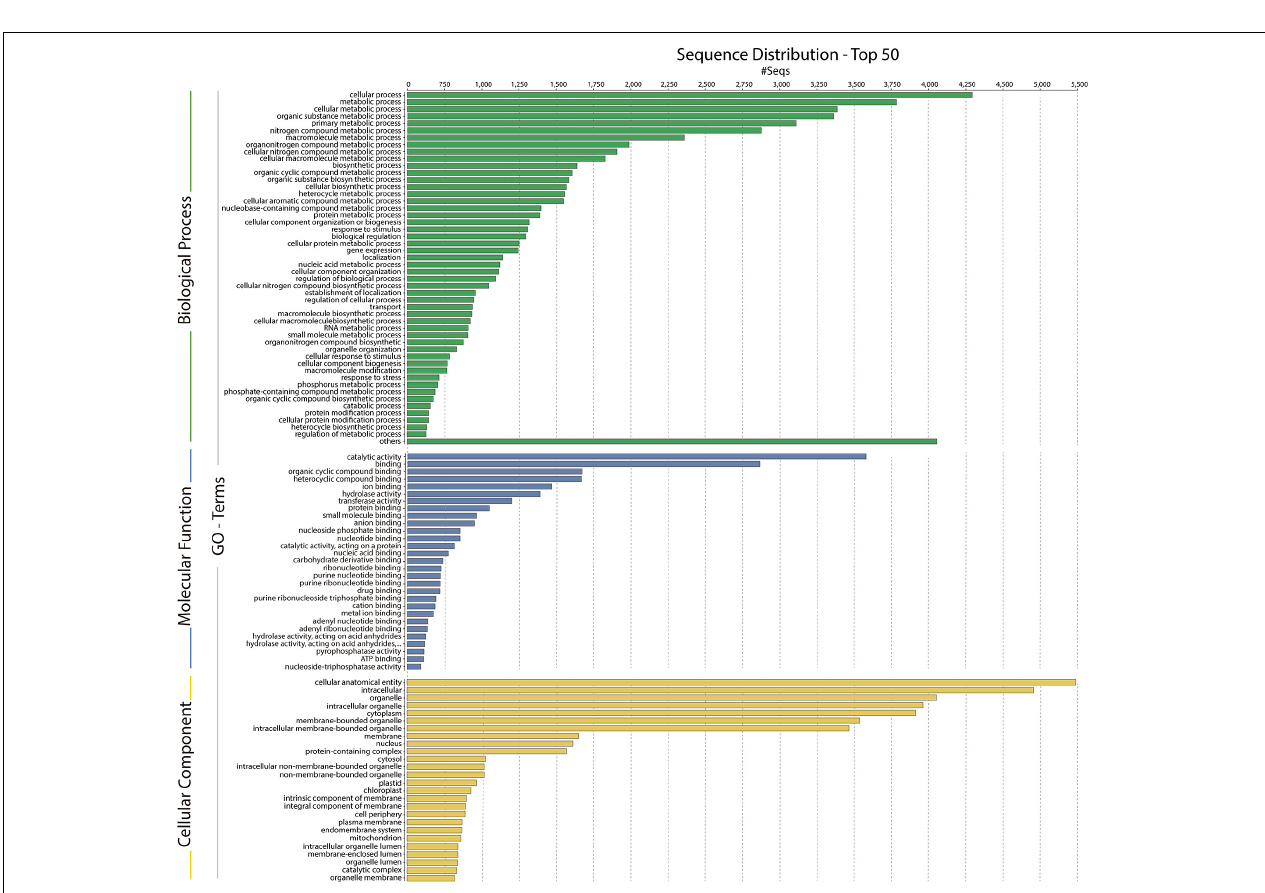
FIGURE 9 | Gene ontology (GO) assignments for the Chlorominima collina CCAP 6/1 transcriptome. Assignments generated in Blast2GO predict the participation of genes in biological processes (green); molecular functions (blue) and cellular components (yellow).